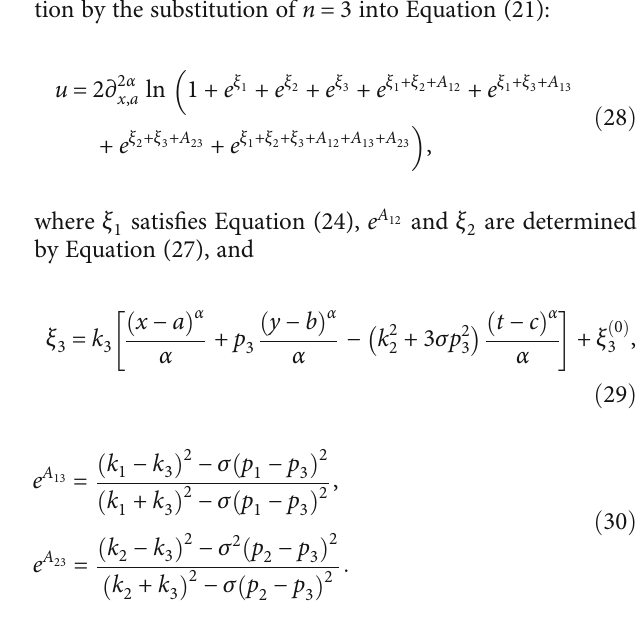
Figure 5: Peakon formed by the fractional one-soliton u with α = 6/11 by selecting a = 1 , b = 1 : 5 , c = 0 , k and t = 0 .